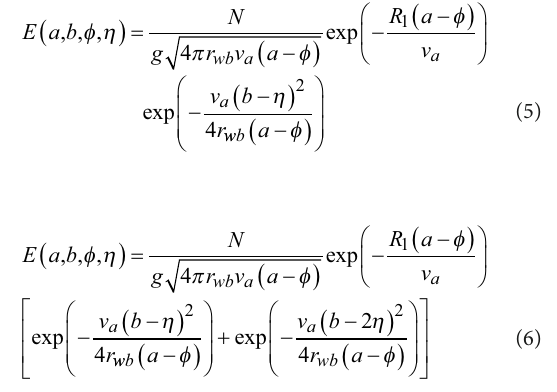
Figure 3 represents the distance from the boundary to the pollution point (Orlandi, 2018; Falco et al.,